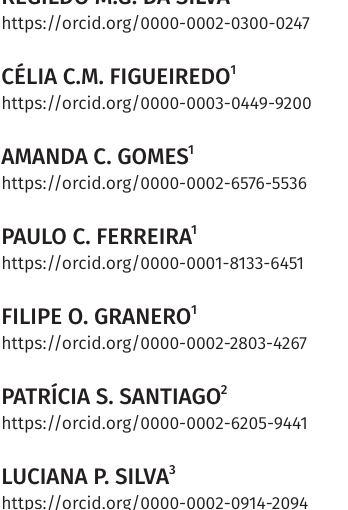
Figueiredo, A.C. Gomes and P.S. Santiago performed antioxidants tests. F.O. Granero performed collecting the plant material and help in writing the manuscript. P.C. Ferreira performed the antigenotoxic assays. This work was done under the supervision of L.P. Silva and R.M.G. Silva. The authors declare that they have no conflict of